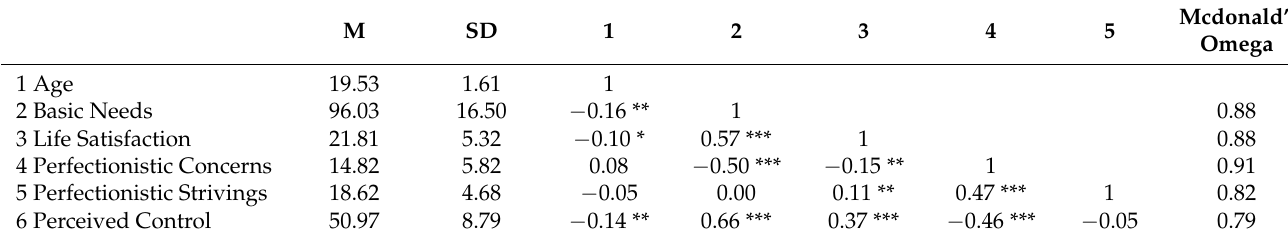
Table 1. The results of descriptive statistics and correlation